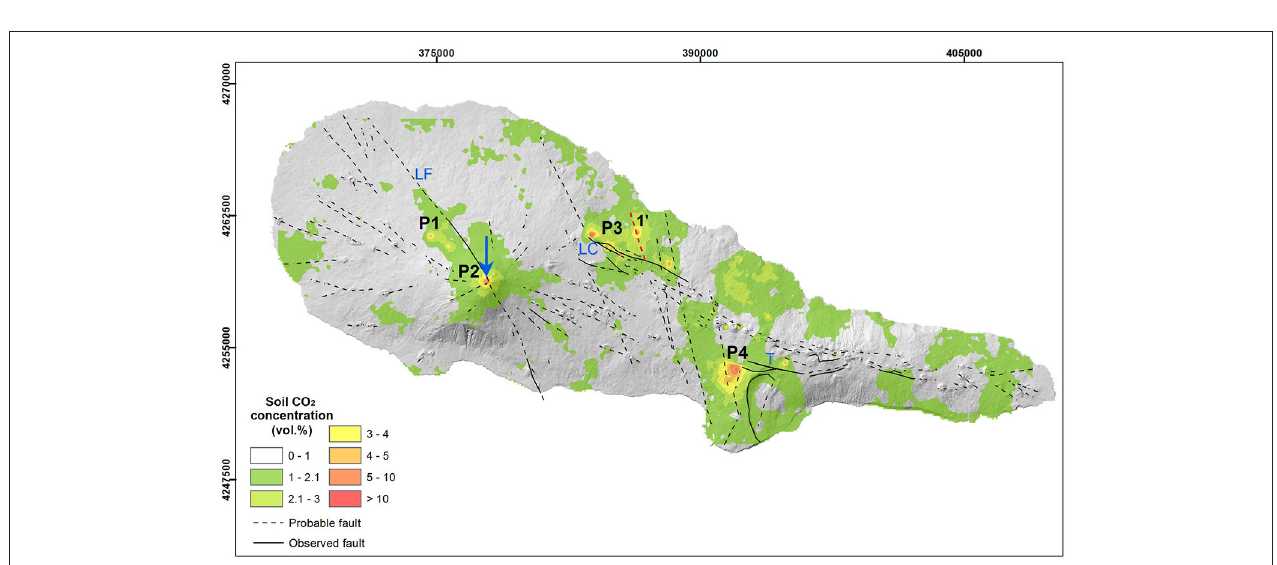
FIGURE 7 | E-type soil CO 2 concentration map for Pico Island (cell size = 50 × 50 m; interpolation method: sGs). Numbers P1–P4 represent the DDS identified at Pico Island (highlighted as orange and red colors) (UTM(m)-WGS84, zone 26S). The blue arrow represents the location of the Pico fumarolic field and red dotted line represents a degassing lineament. Blue letters represent tectonic structures mentioned in the text: LF, Lomba de Fogo-S. João; LC, Lagoa do Capitão; T, Topo.